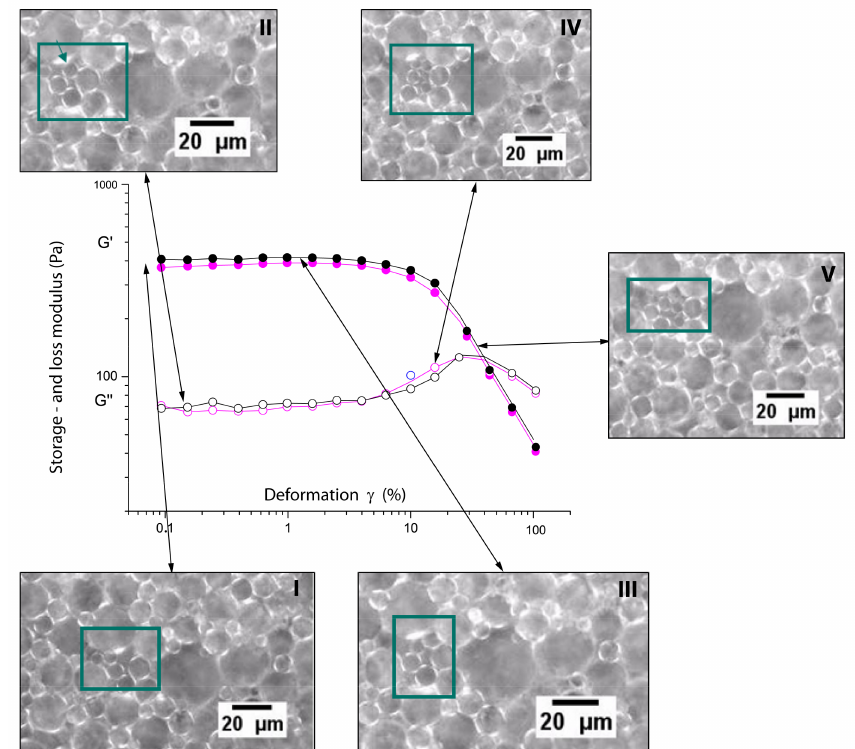
Figure 15. Rheomicroscopy observations for the storage ( G ’) and loss ( G’ ’) modulus from fresh milk emulsions (70% oil) and snapshots at di ff erent deformations. The micrographs I–V correspond to di ff erent shear deformations and are indicated by the arrows. Visible changes are indicated by the rectangles in the